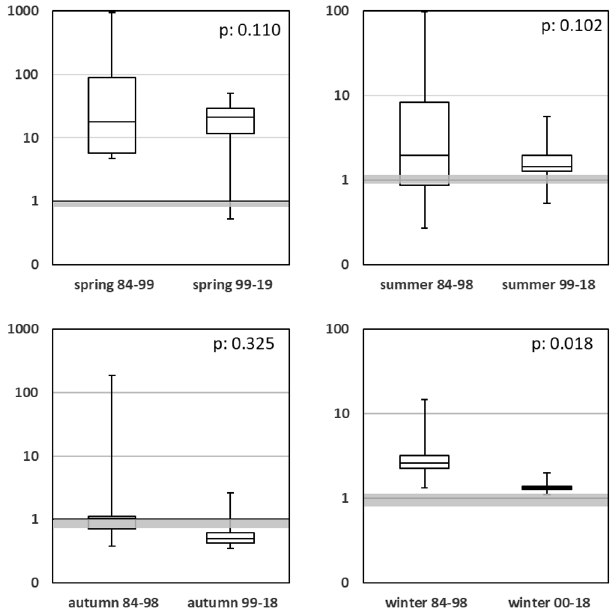
Figure 10. Seasonal comparison of DIN / Si molar ratios for high and low eutrophication periods. The optimum value around 1 is highlighted as a light gray bar. Note the log-scaled y